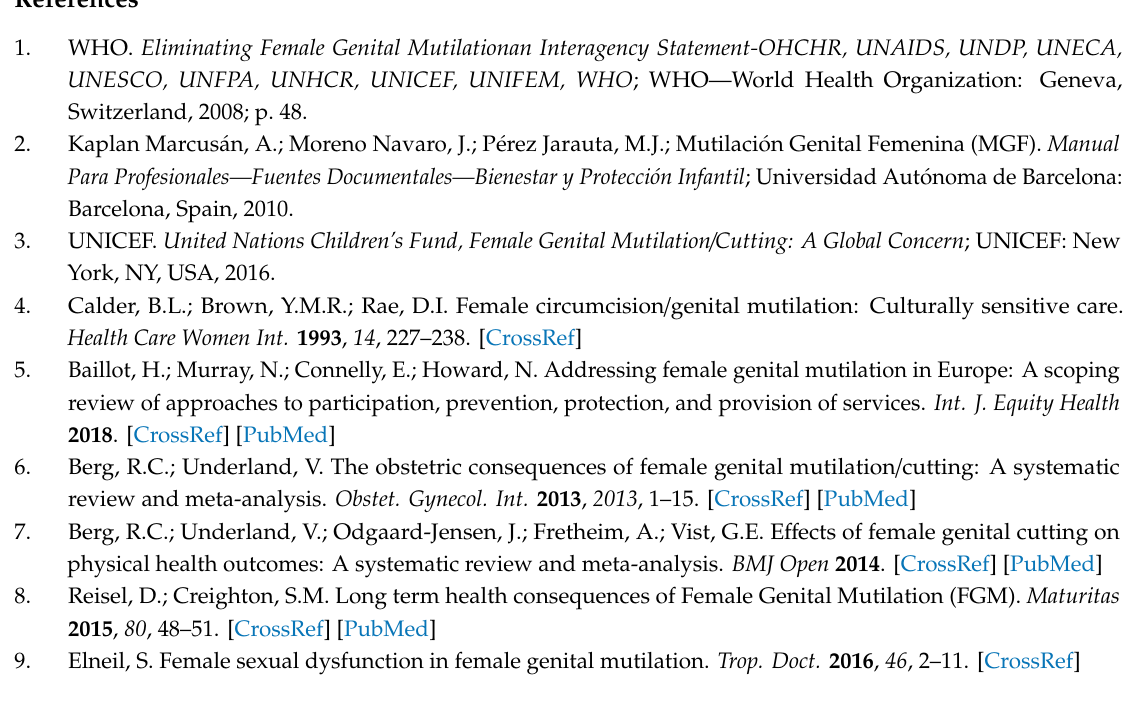
Table S1: Sample characteristics, Table S2: Baseline measures of psychological well-being, depression, anxiety, sexual distress, sexual function, body image, genital self-image, and trauma scores in women with FGM / C. Author Contributions: Conceptualization, J.M.F. and G.M.-B.; Data curation, G.P. and G.M.-B.; Formal